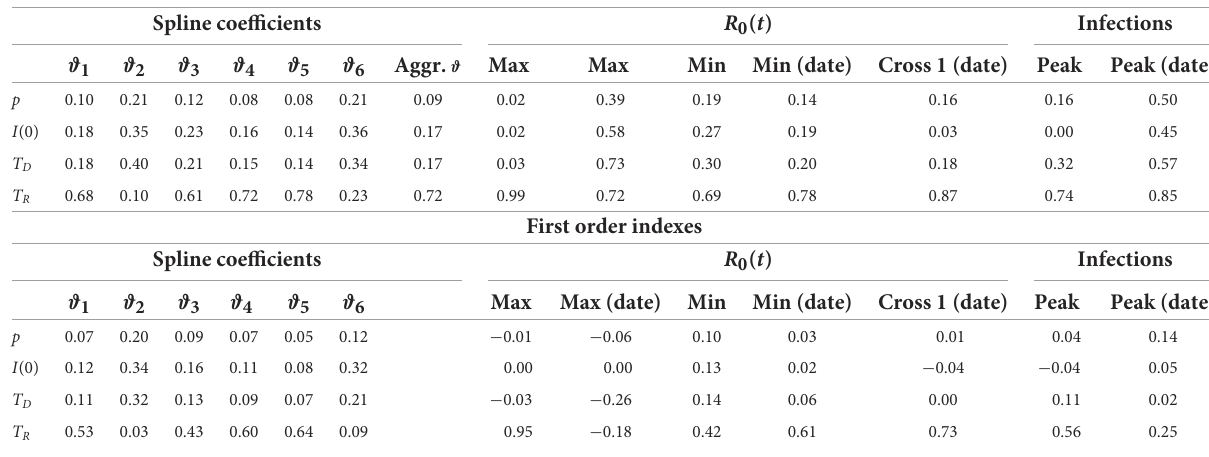
TABLE 2 Total variance indexes and first order indexes of each model input (by row) on the coefficients of the R 0 ( t ) regression spline, maximum and minimum values of R 0 ( t ) with the corresponding dates, date in which R 0 ( t ) first crossed the value of 1, infection peak with the corresponding date (by